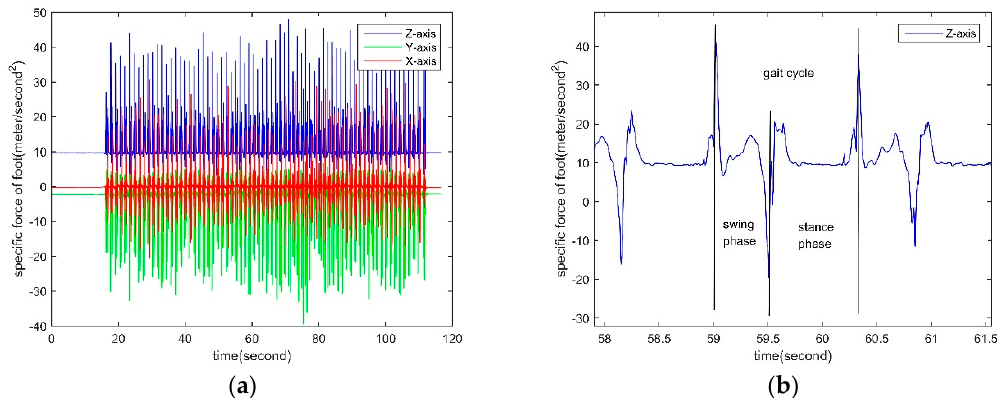
Figure 3. Specific force data of the foot. ( a ) Three-axis specific force data of the foot; ( b ) Partially enlarged for Z-axis specific force data of the foot.